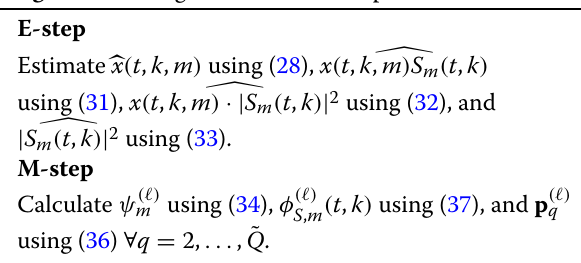
Algorithm 1: Algorithm for EM-steps.